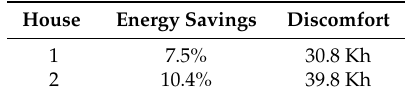
Table 14. Results for Case 2A.